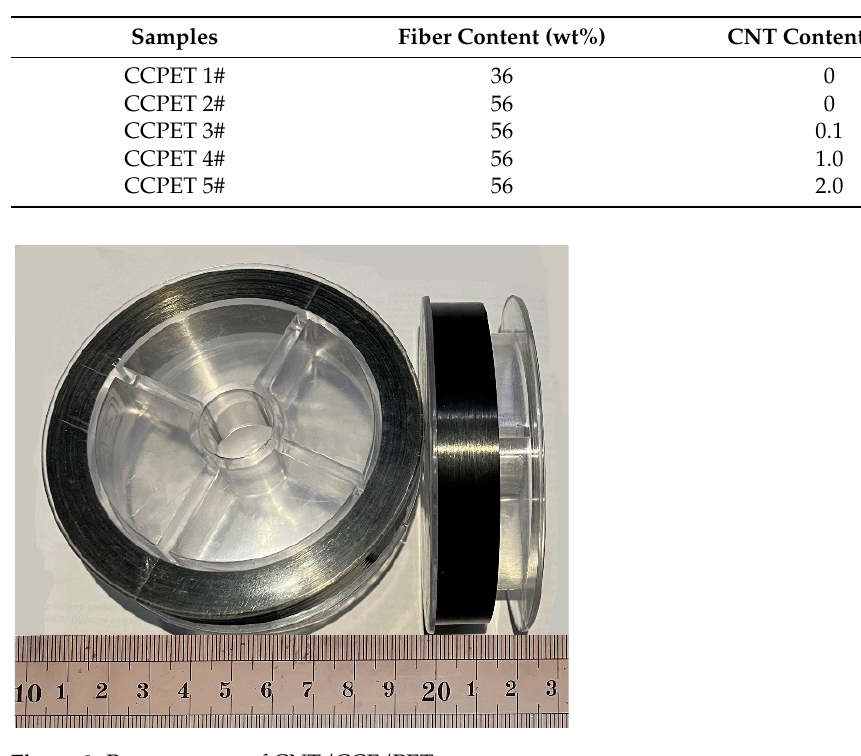
Table 2. The formula of the prepreg tape.